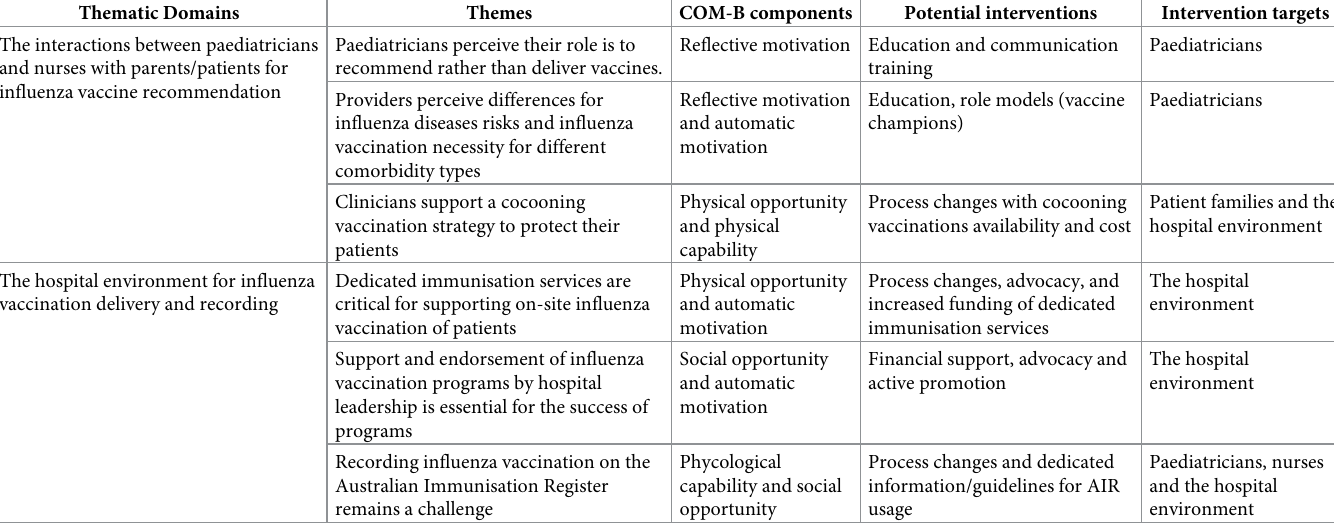
Table 2. Domains, themes, COM-B components, interventions, and targets. Thematic Domains The interactions between paediatricians and nurses with parents/patients for influenza vaccine